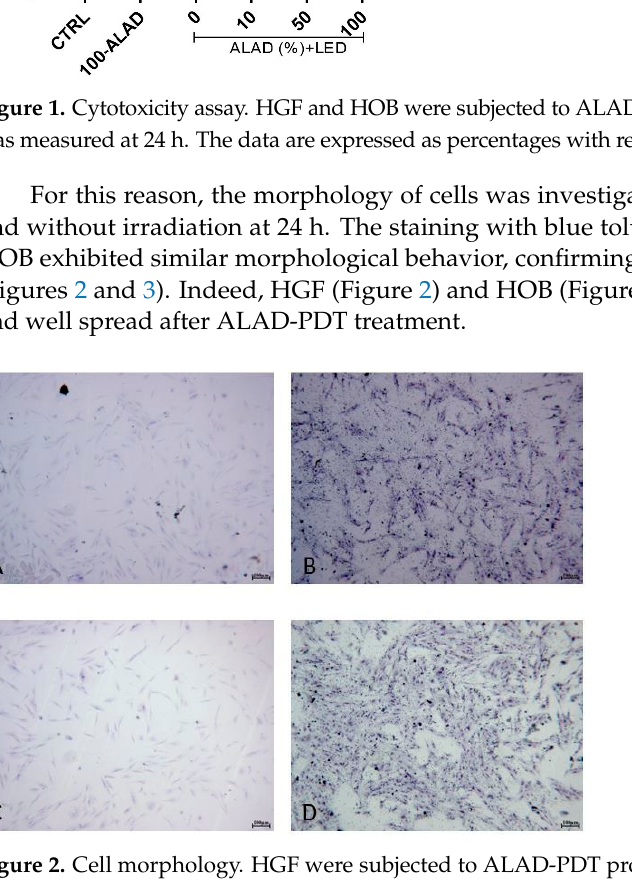
Figure 3. Cell staining. HOB were subjected to ALAD-PDT protocol and stained after 24 h with toluidine blue. ( A ) CTRL, ( B ) 0-ALAD-PDT, ( C ) 100-ALAD, ( D ) 100-ALAD-PDT . 2.2. Cell Proliferation after ALAD-PDT Based on the results of the LDH, both cell types were incubated with increasing doses of ALAD for 45 min, and after that, exposed to light to assess their proliferative activity using the MTS assay at 48 h and 72 h. The number of viable and metabolically active cells